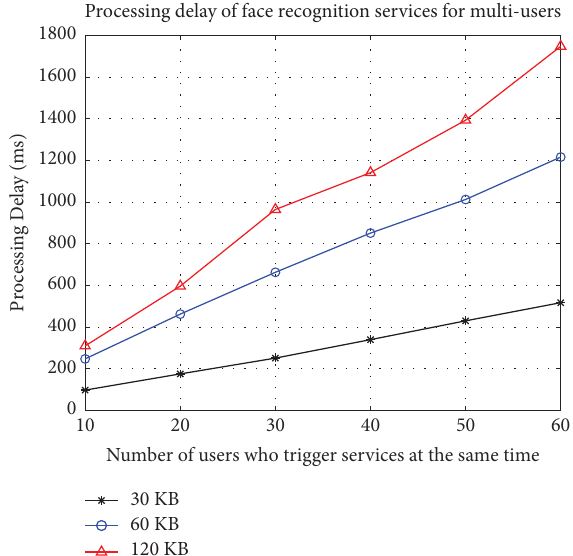
Figure 9: Te processing time for intelligent